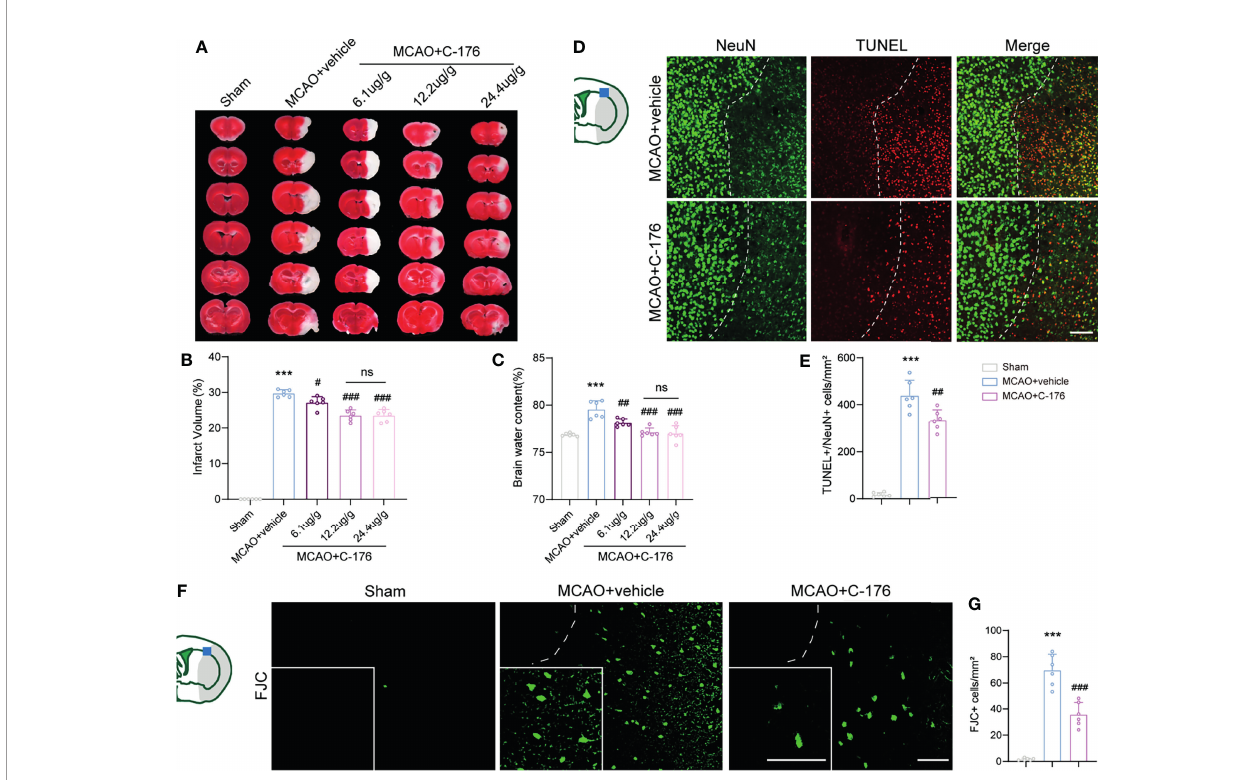
FIGURE 2 | C-176 treatment rescued infarct volume, brain edema, and neuronal injury. (A) Representative images for TTC staining in the indicated groups. (B, C) Quantitative analysis of infarct volume and brain edema in treated mice 1d post-modeling. (D, E) Representative microphotographs and quantitative analysis of NeuN/TUNEL co-staining. The dotted lines designate infarct borderlines. (F, G) FJC staining showed that the density of FJC-positive cells was increased in the peri-infarct area, while C-176 treatment reversed this trend. Insets show a higher magni fi cation view. n = 6. Data are expressed as mean ± SD. *** P < 0.001 vs Sham group; # P < 0.05, ## P < 0.01, ### P < 0.001 vs MCAO+vehicle group. n. s., no signi fi cant difference. Scale bar = 50 m